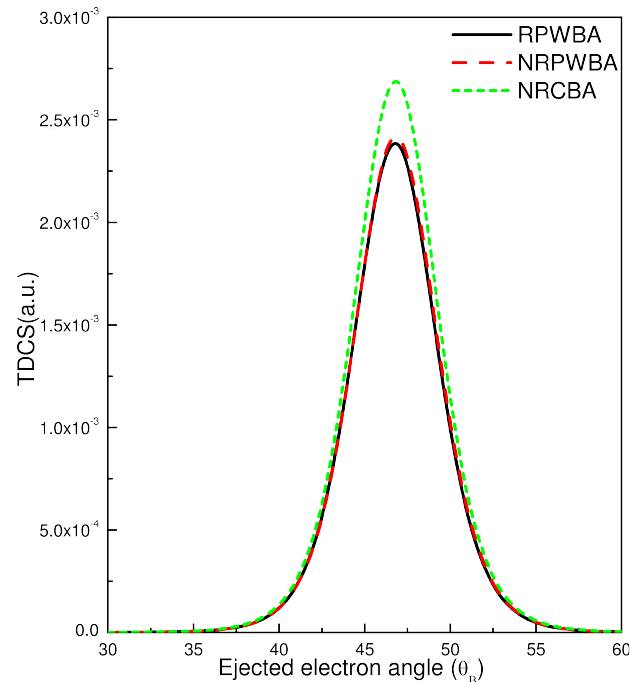
Figure 1. The incident positron kinetic energy is T i = 2700 eV, the ejected electron kinetic energy is T B = 1249.5 eV and geometric parameters are ϕ i = ϕ f = 0 ◦ , ϕ B = 180 ◦ , θ i = 0 ◦ and θ f = 45 ◦